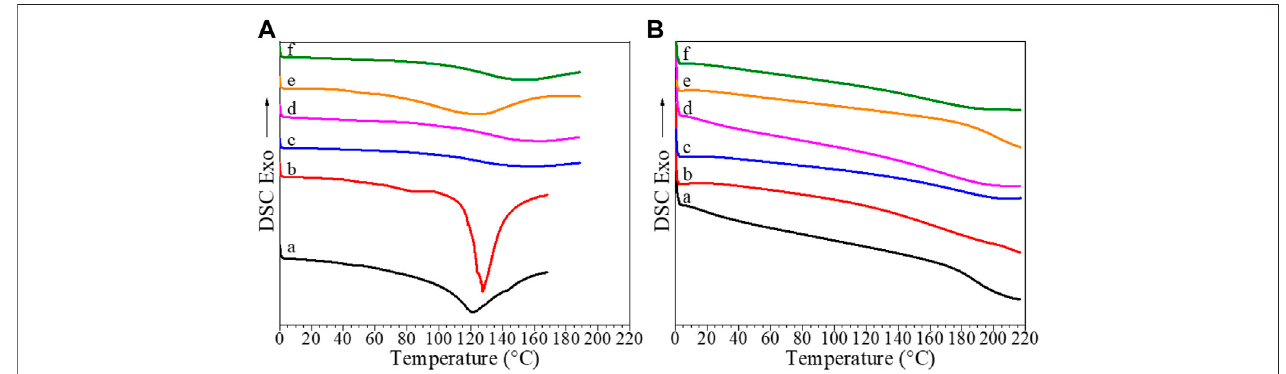
FIGURE3| DSCcurvesrecordedduring (A) fi rstand (B) secondheatingrunsfor(a)pristineCS,(b)CS/B,(c)CS/B/025G/025C,(d)CS/B/05G/05C,(e)CS/1G/1C, and (f) CS/B/1G/1C.